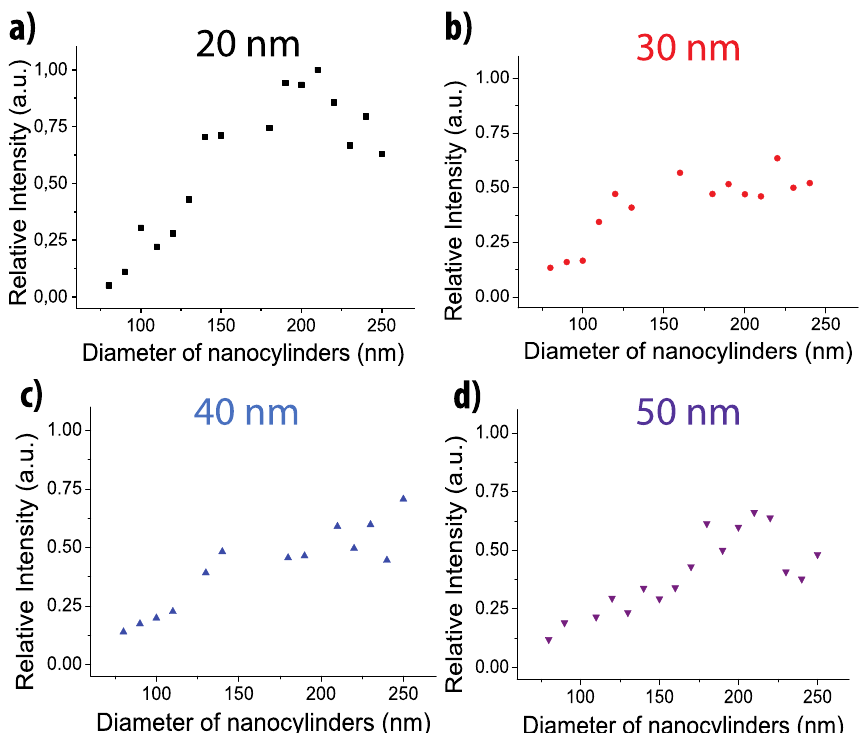
Figure 5. Evolution of the SERS intensities of the band located at 1580 cm −1 depending on the nanocylinder diameter and for the four film thicknesses: ( a ) 20, ( b ) 30, ( c ) 40, and ( d ) 50 nm. Excitation wavelength: 532 nm. Points size includes the error bars.